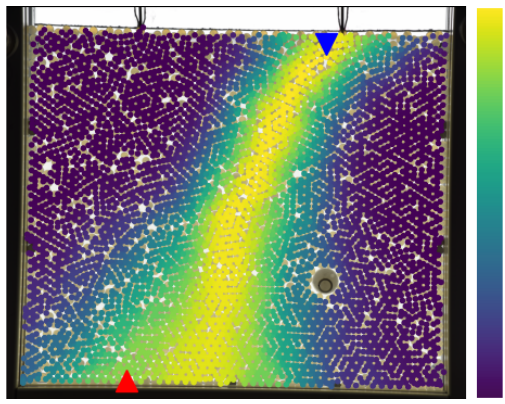
Figure 3. Probability field according to the sensor pair (3, 5). Higher values represent higher probability. The maximum ridge is roughly shaped like a hyperbole. The predicted source (blue downward triangle) is far from the actual source (red upward tri- angle). Notice an active grain at approximately 2 / 3 right and bottom of the cell (see explanations in the text).